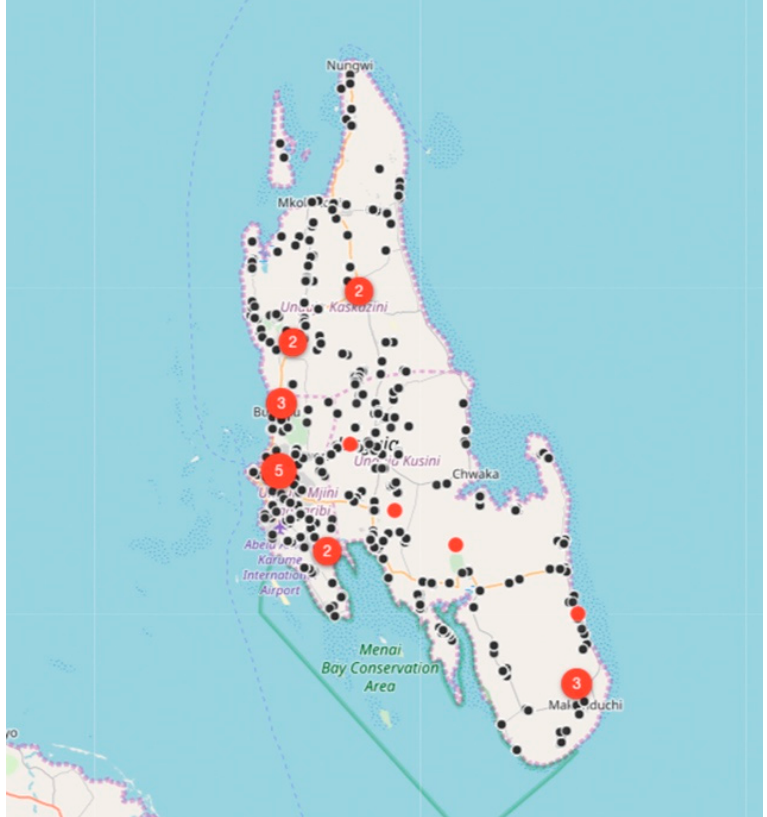
Figure 3. Maps of Unguja island showing the location of laboratory-confirmed animal rabies cases (red dots) and locations of vaccinated animals in 2017 (black dots). The number of rabies cases per location is displayed in terms of the size and the number within each red dot, while only the location of the vaccinated animals is displayed on the map (black dots) for ease of interpretation. On this specific map, the total number of black dots represent the 2900 animals vaccinated between August 2017 and December 2017.